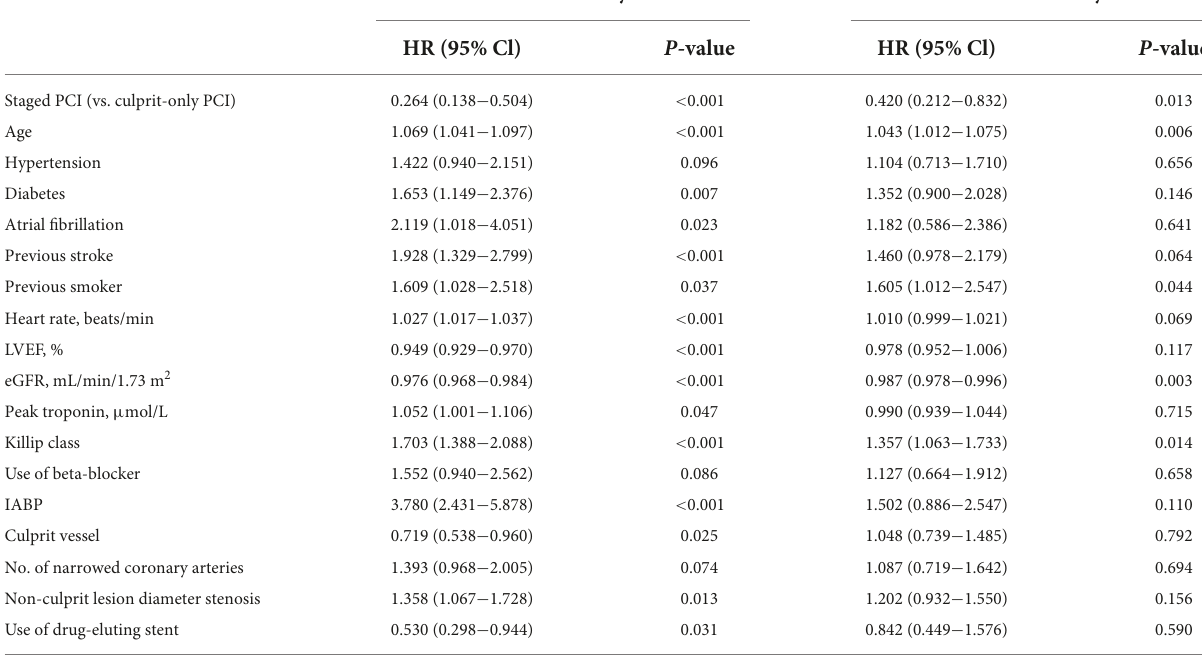
TABLE 5 Cox proportion hazards analysis for predictors of all-cause death before PSM analysis.